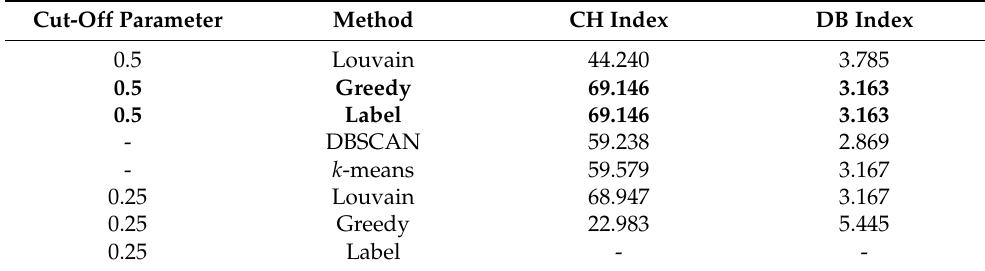
Table 9. Calinski–Harabasz (CH) and Davies–Bouldin (DB) index values for the different methods and different cut-off parameters (wholesale customers).